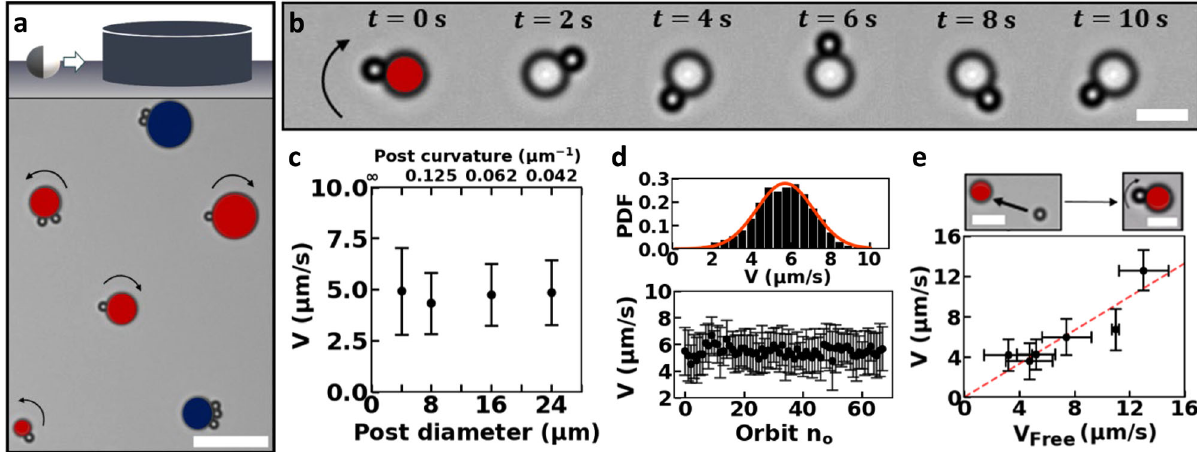
Fig. 1 Catalytic microswimmer motion along circular posts: single-particle orbiting. a Schematic of the experimental setup (top) and light microscopy image (bottom) of the corresponding experiment: catalytic microswimmers orbit circular 3D posts, microprinted on planar substrates. Scale bar is 20 μ m. Coloring is used to distinguish the stationary posts from our swimmers, and indicates whether the attached swimmers were mobile (red posts) with the arrow denoting their direction in orbit, or immobile (blue posts) due to the swimmers initially orbiting toward opposing directions. b Time series of light microscopy images of a (2.00 ± 0.05) μ m diameter swimmer orbiting a 4 μ m diameter post, with the arrow denoting its constant direction of motion. Scale bar is 5 μ m. c Propulsion speed along the post as a function of post diameter. All data were taken at otherwise fi xed experimental conditions. d Top: propulsion speed of an individual swimmer in orbit follows a Gaussian distribution. Measurement duration was 4 min. Bottom: same propulsion speed data plotted as a function of number of orbits. e Propulsion speed for the swimmers before orbiting, i.e., free speed on the planar substrate, plotted against their speed in orbit. The dashed line is a least-squares fi t with y = ax and a = 0.83 ± 0.08, in line with Ref. 14